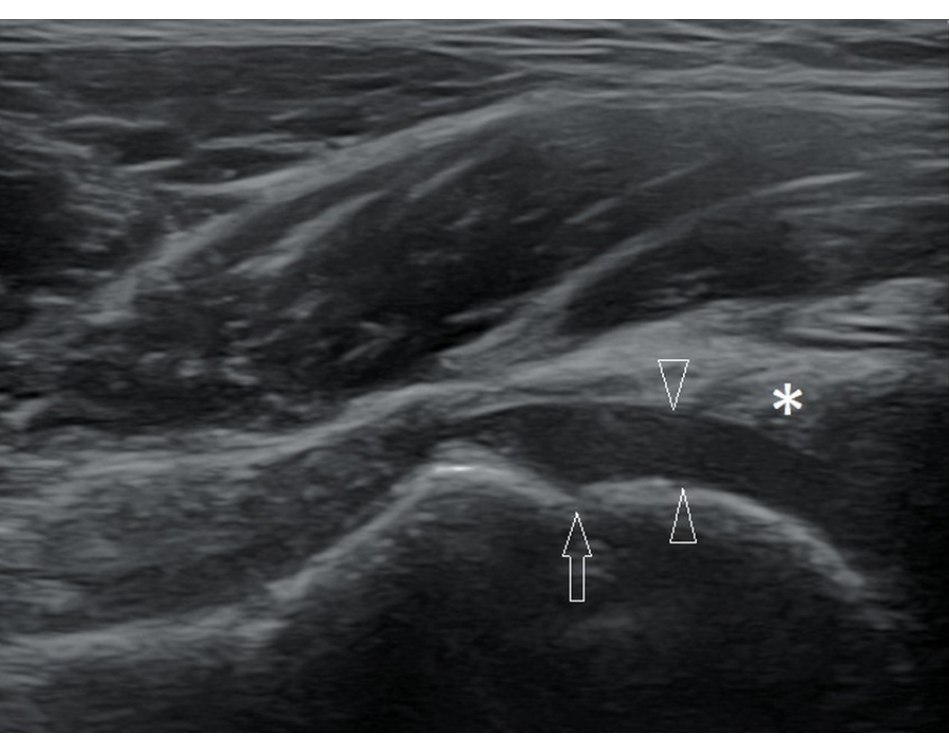
Figure 2. Frontal plane scan of the right acromioclavicular joint of 11-year-old boy. ACR—acromion; CLAV—clavicula; arrowheads—cartilaginous ends of acromion (left side of the image) and clavic- ula (right side of the image). Linear probe 3–12 MHz.